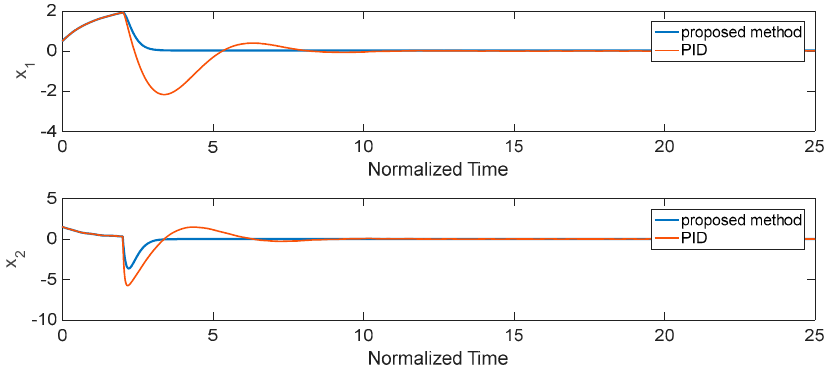
Figure 3. Time history of states of the system based on the proposed method and PID controller.